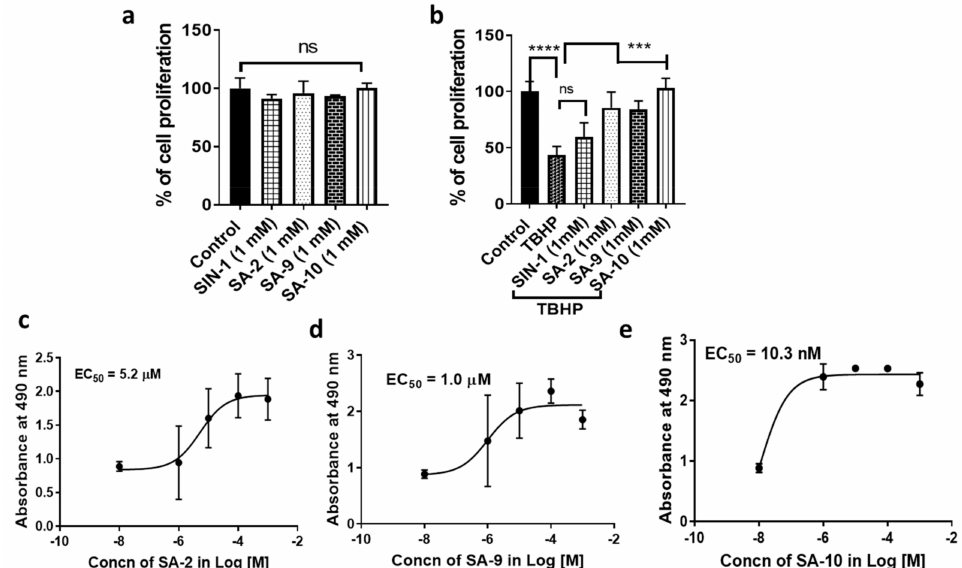
Figure 5. Effect of SA compounds in NTM-5 cell proliferation. ( a ) The % of cell proliferation measured by MTT assay represented cell viability after treatment of SA compounds to NTM-5 cells for 18 h of treatment. ( b ) Treatment with TBHP (350 µ M) significantly decreased the NTM-5 cell proliferation. Treatment with SA compounds rescued the cell from death. ( c – e ) Compounds SA-2, SA-9 , and SA-10 dose-dependently increased the number of viable NTM-5 cells that was decreased significantly in the presence of tert -butyl hydroperoxide (TBHP, 350 µ M). Experiments were repeated three times with n = 4 technical replicates. Values are expressed in mean ± standard error of the mean (SEM). EC 50 values were calculated using GraphPad Prism. *** p < 0.001, **** p < 0.0001. One-way ANOVA, Graph Pad